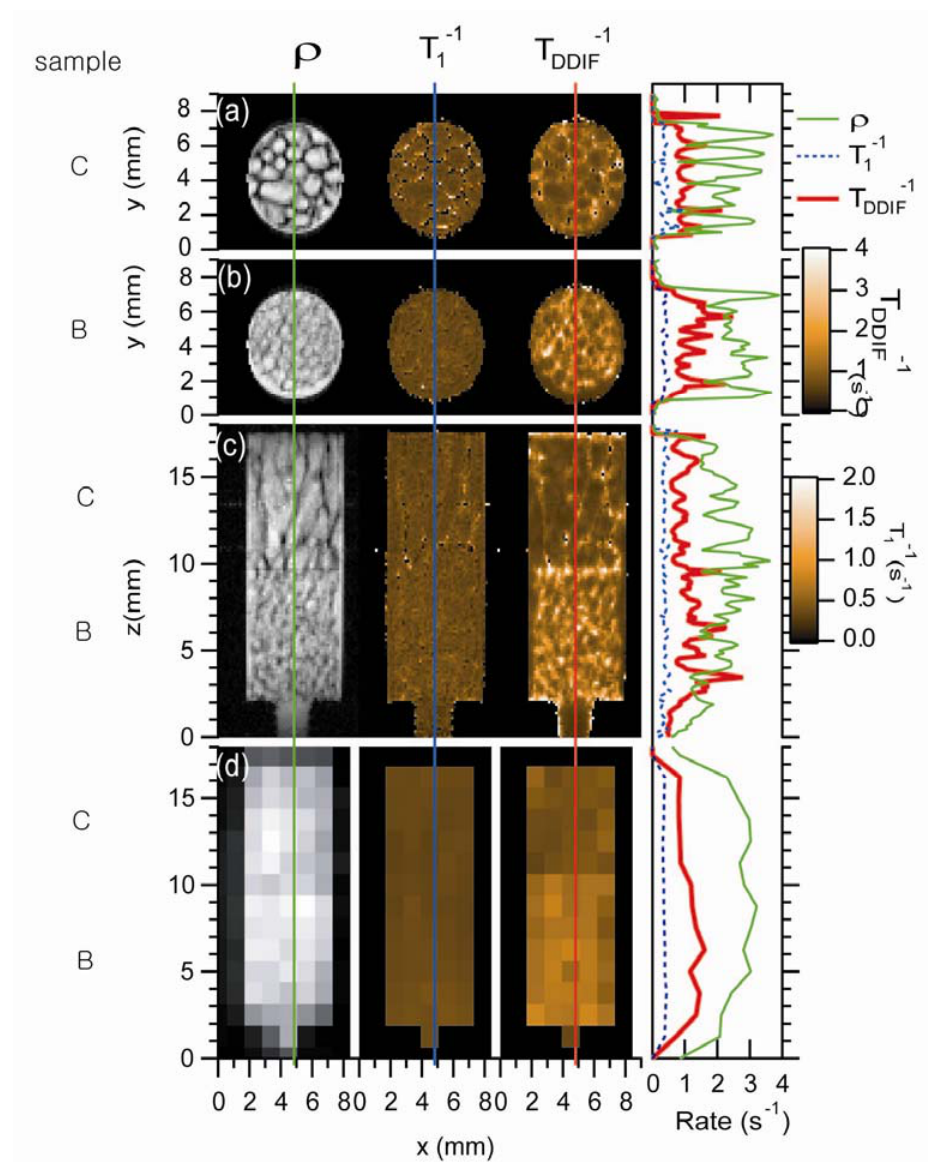
Figure 10. Experimental DDIF microimaging. Spin-density images are shown in the first column. The second column shows a map of the spin-lattice relaxation rate. The third column shows a map of DDIF decay rates. The fourth column shows 1D profiles through the centers of each image, as indicated by the vertical lines. The first and second rows show axial images of samples C and B, respectively. The third row shows high-resolution coronal images of both samples B and C together, and the fourth row shows low-resolution coronal images of samples B and C. Reproduced from Reference [24] with